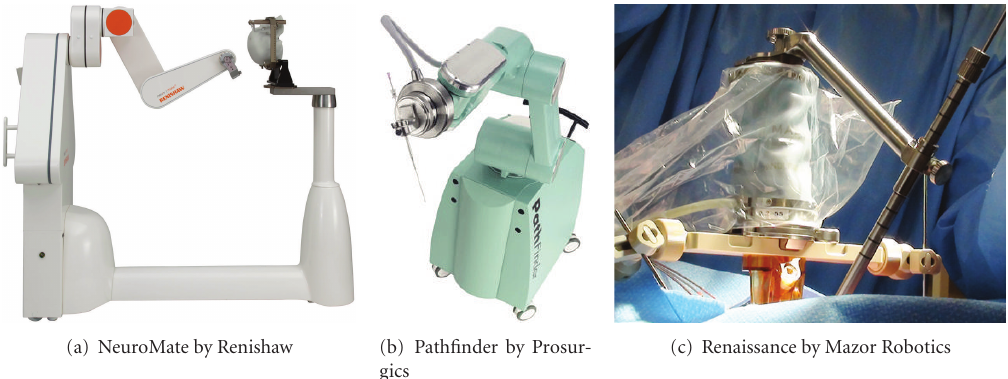
Figure 1: Neurosurgery robots for image-guided tool positioning/orientation. The NeuroMate image is ©2012 Renishaw. The Pathfinder image is ©2012 Prosurgics. The Renaissance image is ©2011 Mazor Robotics Ltd. All rights reserved with nonexclusive permission.